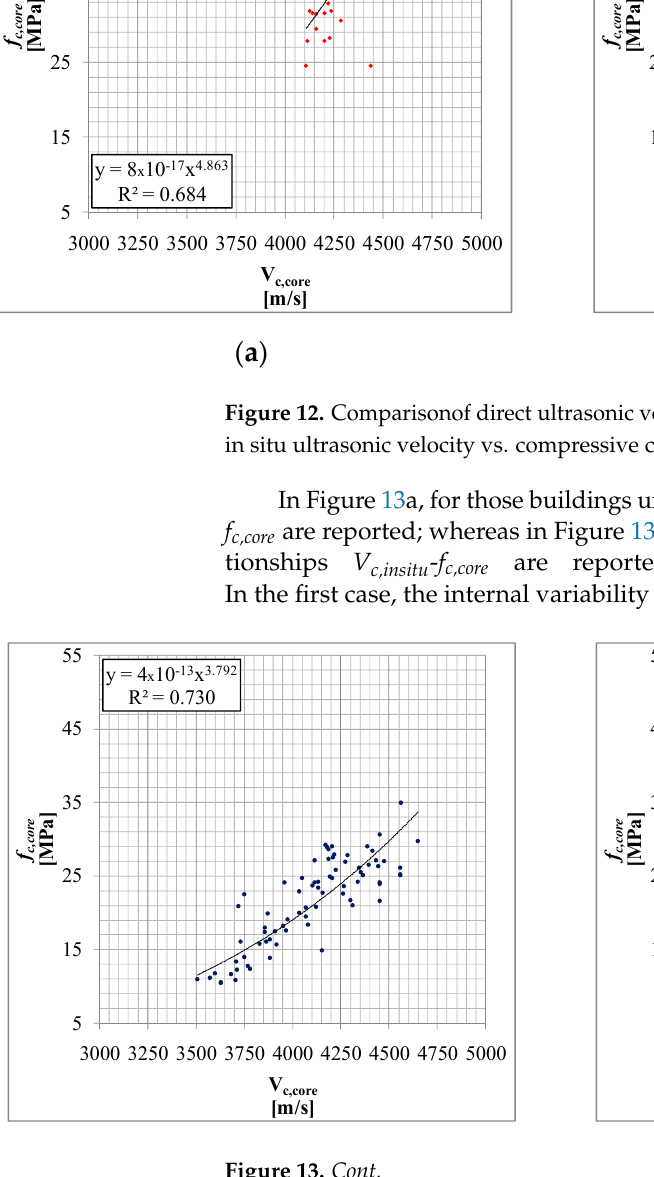
y = 8 x 10 -17 x 4.863 R² = 0.684